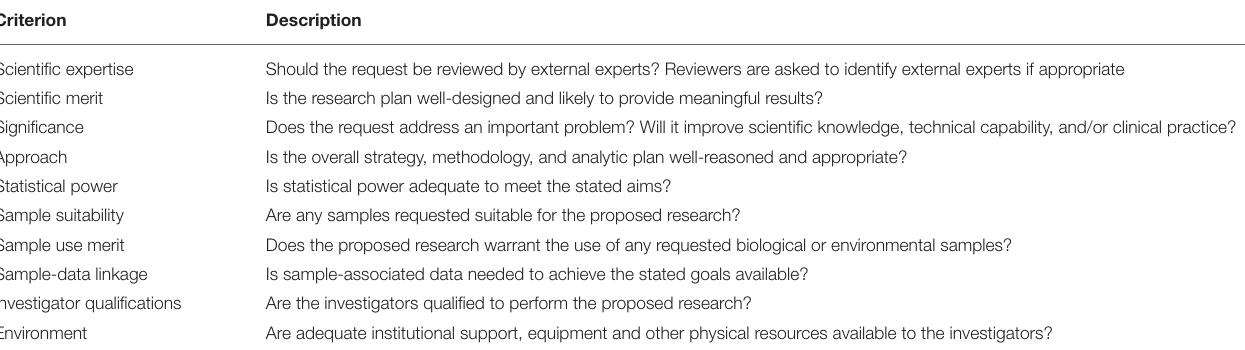
TABLE 6 | NCS archive request review criteria.